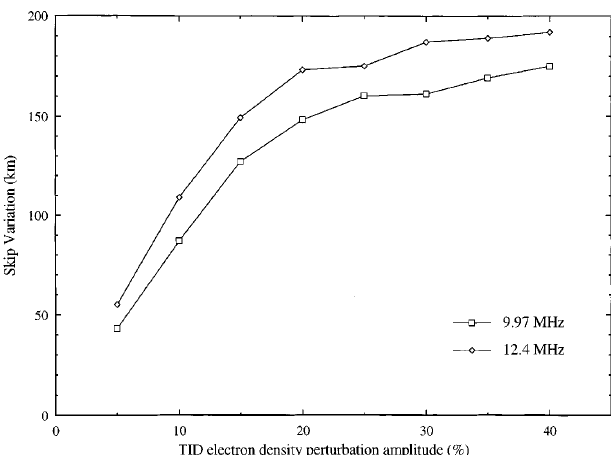
Fig. 7. The modelled skip variation as a function TID perturbation amplitude for two radar